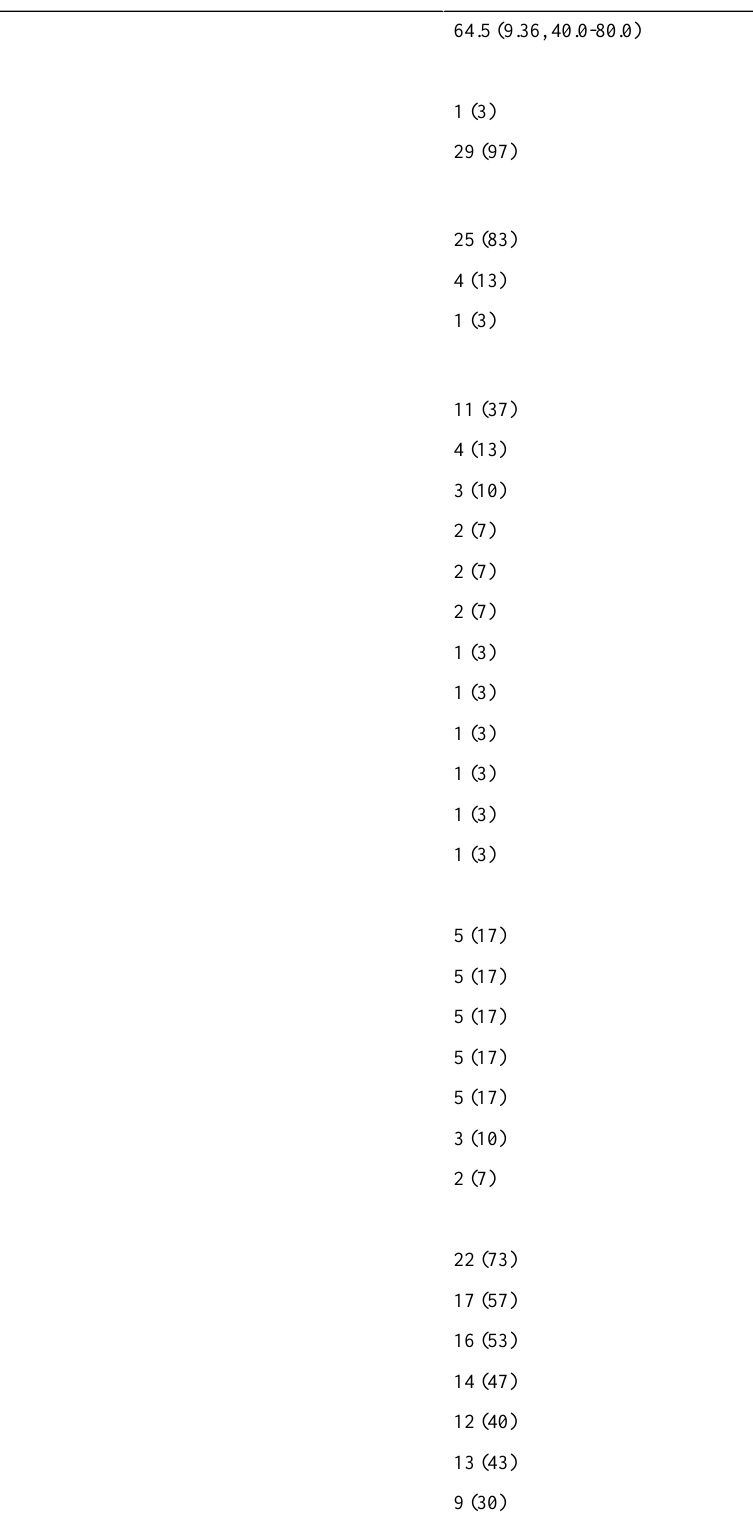
Table 1. Participant demographics (N=30).